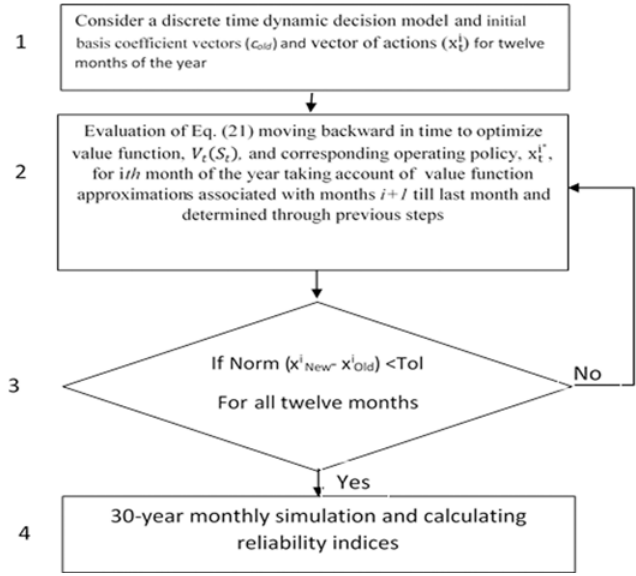
Fig 2. Illustration of solving Eq 21 for each month along the year moving